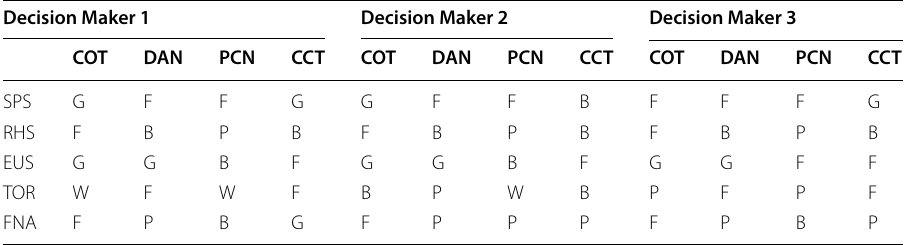
Table 10 Linguistic evaluations for the